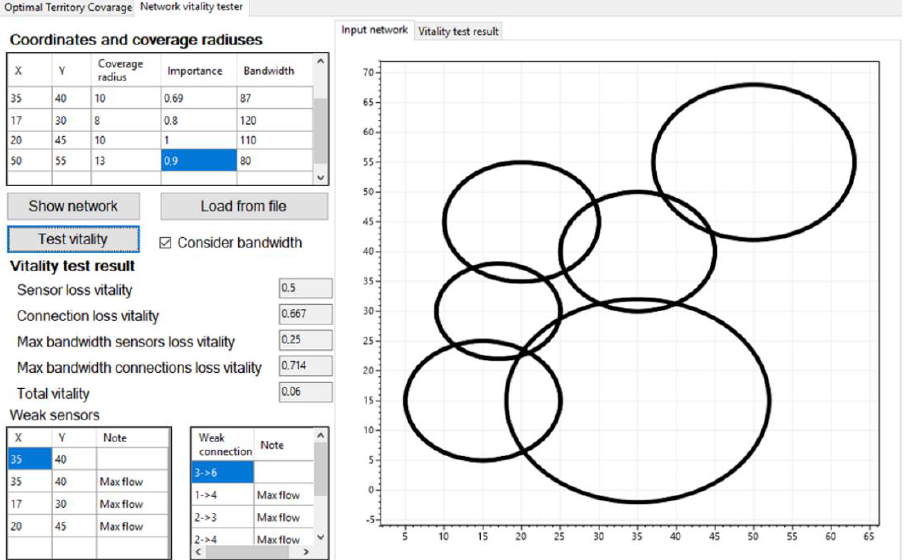
Figure 12. Sensor network’s survivability estimation result s considering bandwidth.